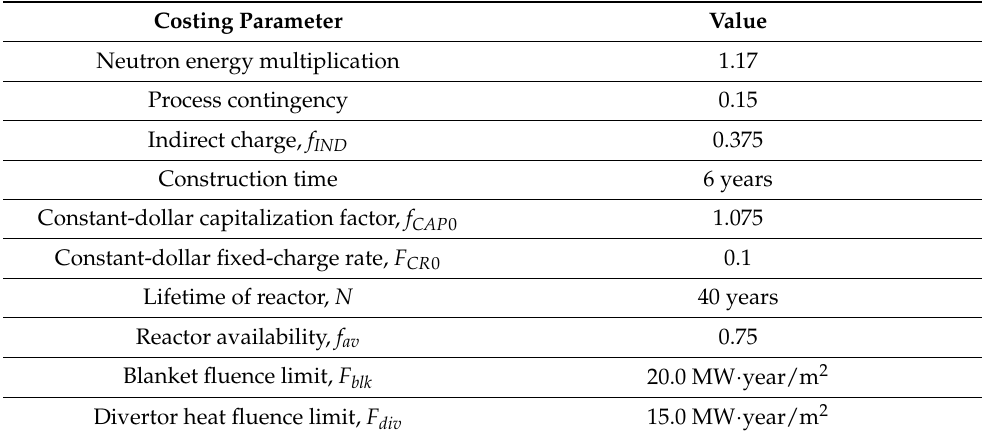
Table 3. Costing